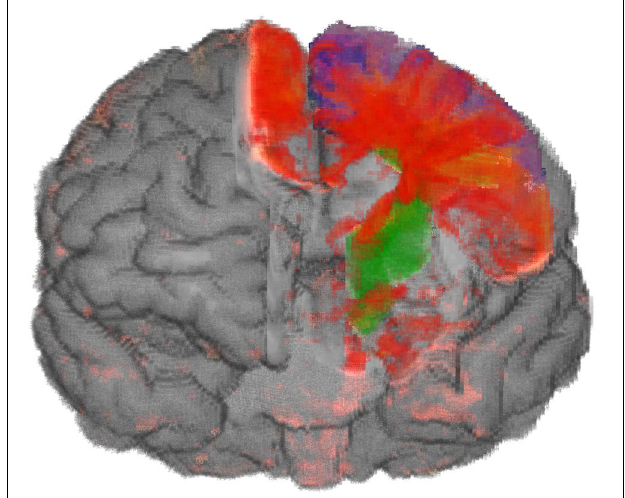
FIGURE 7 | Atrophic part of the brain (red to yellow) of a person with CBS and maps of anatomical regions (blue premotor cortex, green cortico-spinal tract). The removed part of the brain is adjusted to the selected anatomical regions. The overlap between atrophic parts and anatomical regions can be recognized by the blending of different